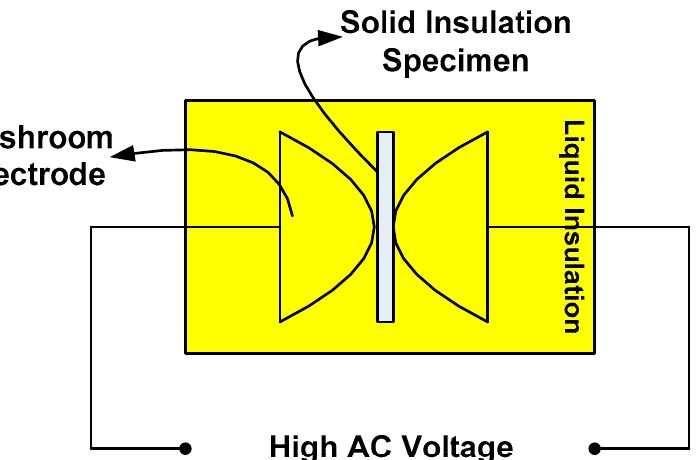
Figure 3. Experimental setup for breakdown strength of transformer oil samples.